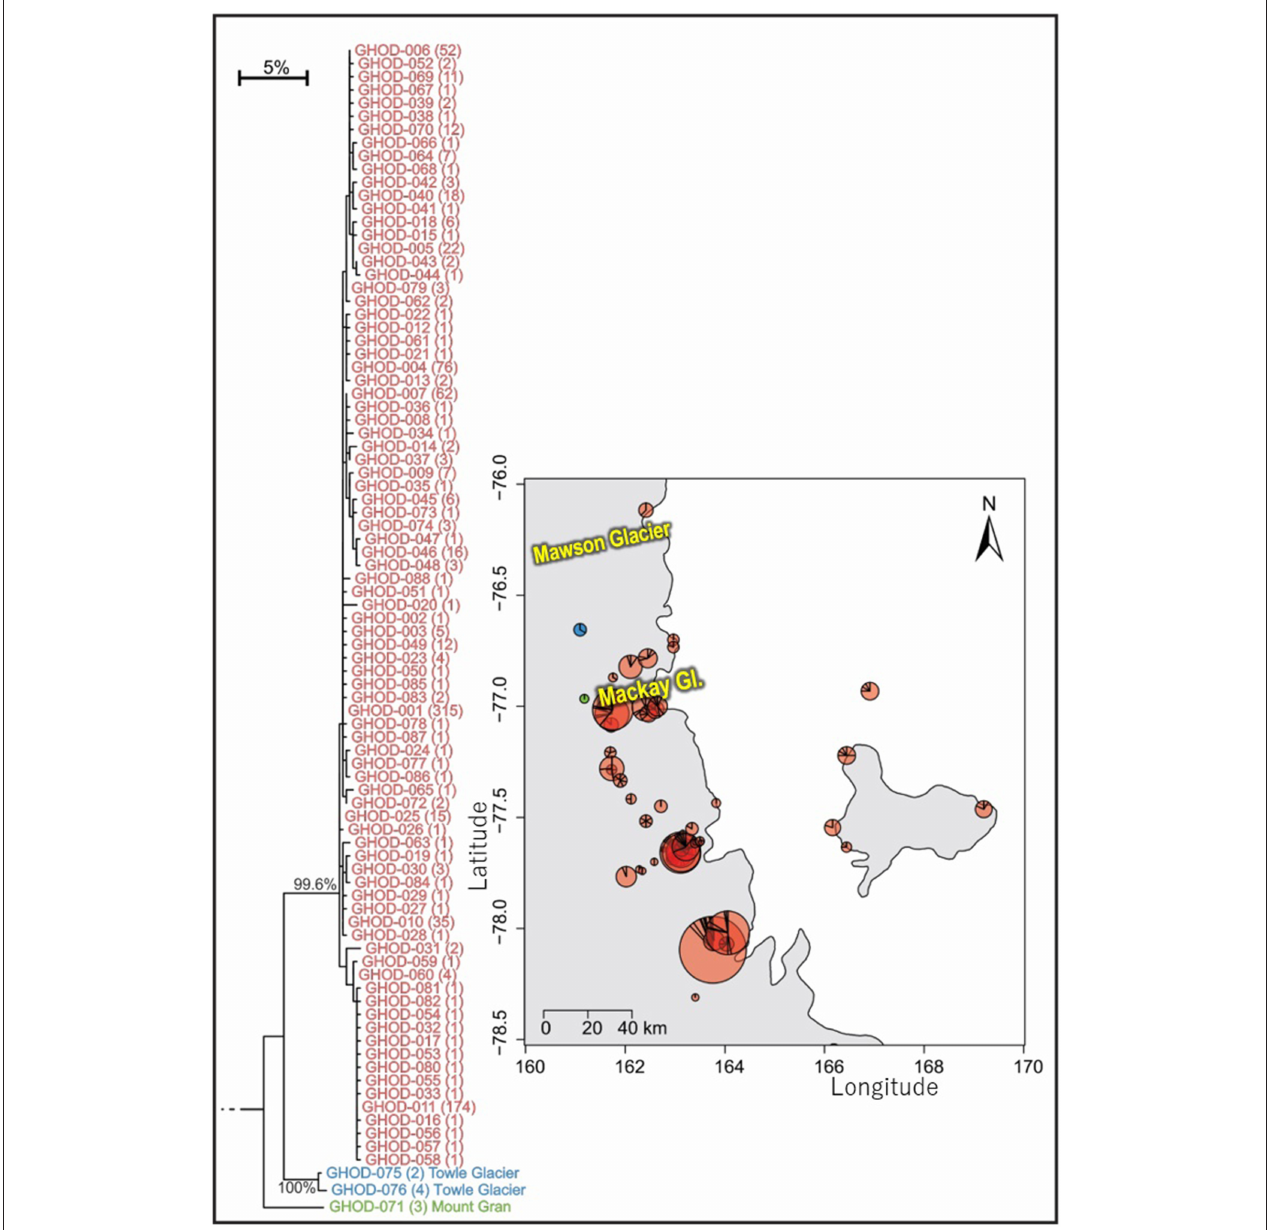
FIGURE 7 | Geographical distribution of the three distinct (5.9–7.3% mean divergence) lineages of Gomphiocephalus hodgsoni within southern Victoria Land for specimens where collection data were available (GHOD; n = 904; 422 bp), showing widespread distribution (500km reach) of the main group of haplotypes ( n =